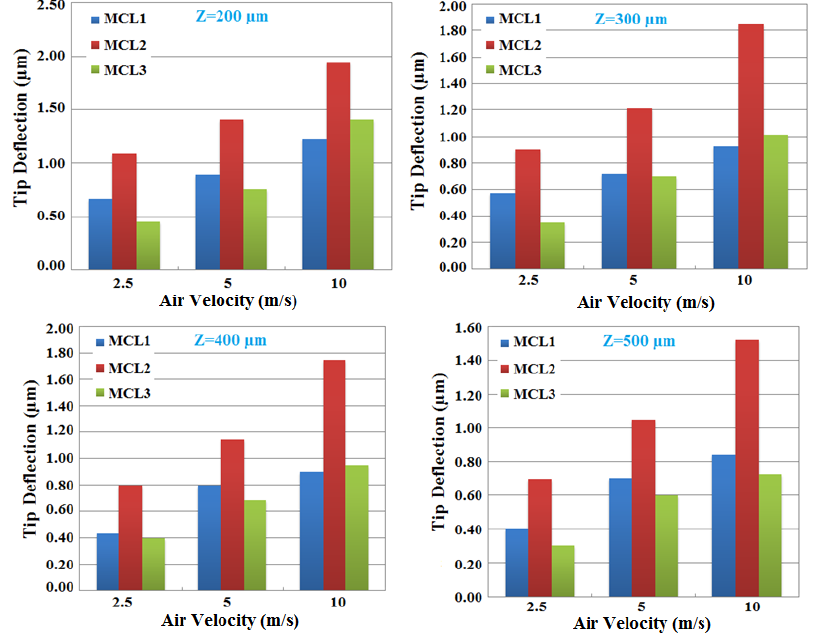
Figure 10. The effects of the vertical distance between MCL 250 µm lengths for different air velocity. All simulation was run by COMSOL and the tip deflection results were extracted for different values of velocity blowing from the tip of microneedle. There are some cross-talking when the needle is above the central MCL and air is directed on the central part of its upper surface.